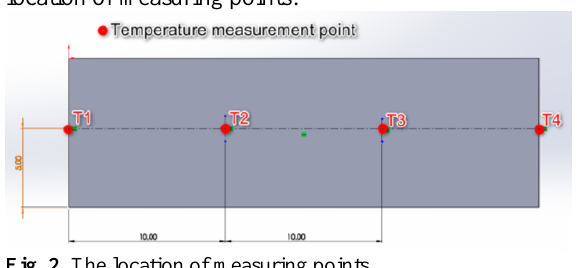
Fig. 2. The location of measuring points. Table 1. Workpiece